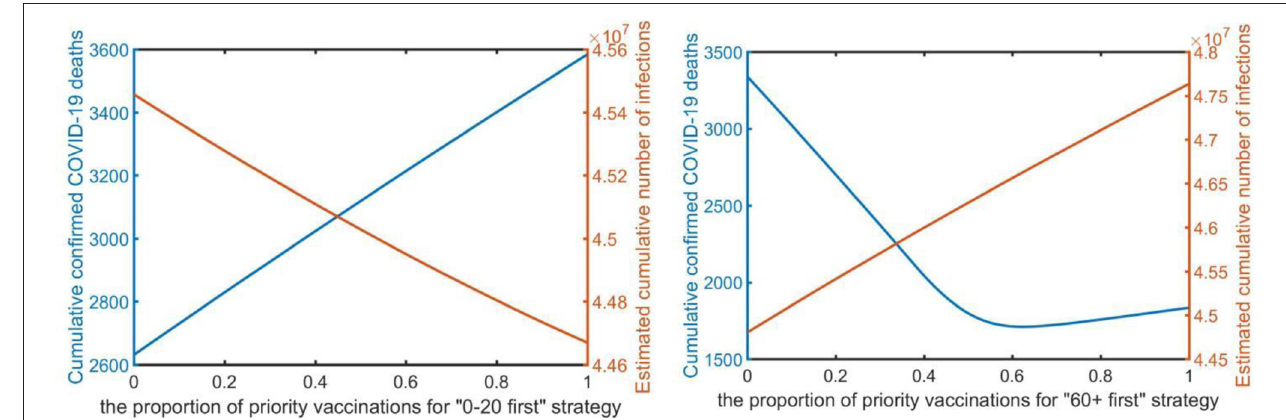
FIGURE 4 | The proportion of the vaccination priority under the “0–20 first” strategy and “60 + first” strategy ( x -axis) to minimize the total number of infections and deaths ( y -axis).